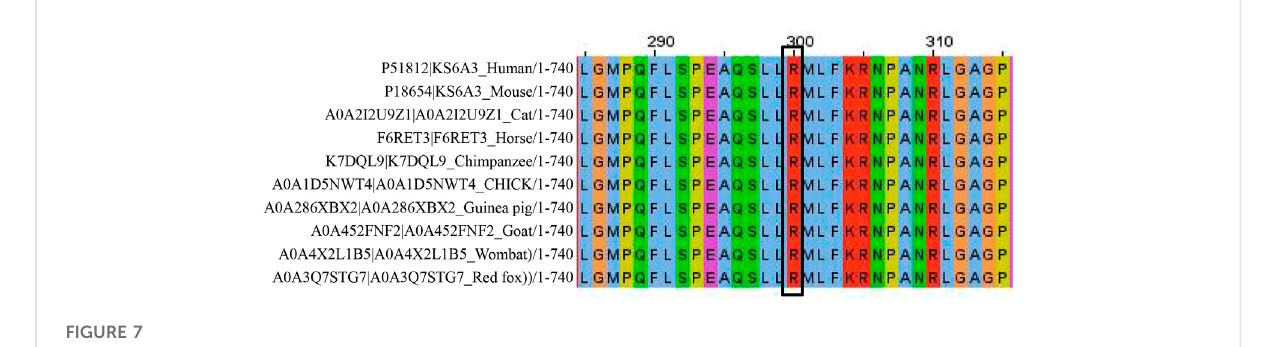
FIGURE 7 In total, 30 amino acids surrounded the variant position (marked with a black box).